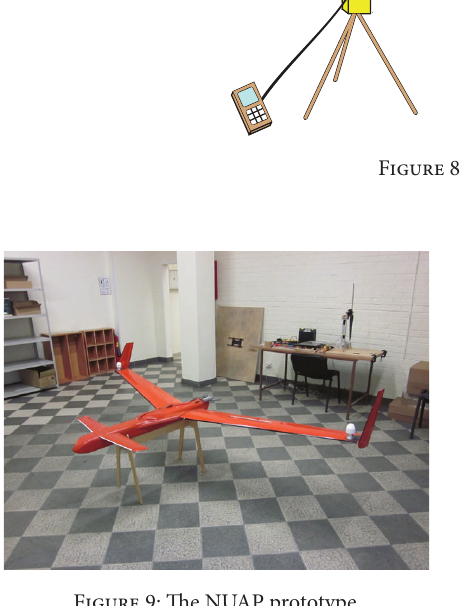
Figure 9: The NUAP